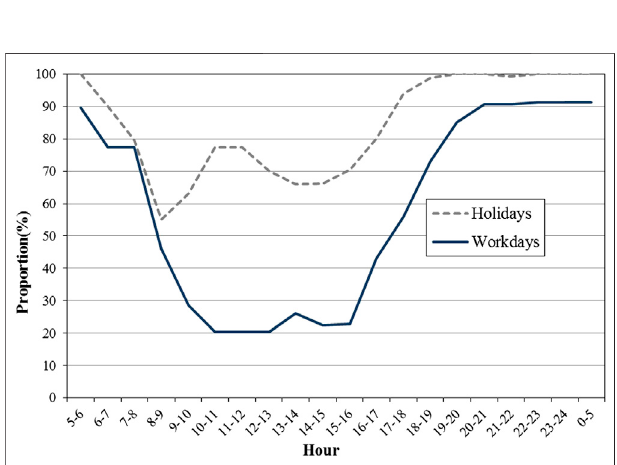
FIGURE2| DistributionofbuildingvulnerabilityvaluesinLuomovillage(T (cid:2) 100 a).